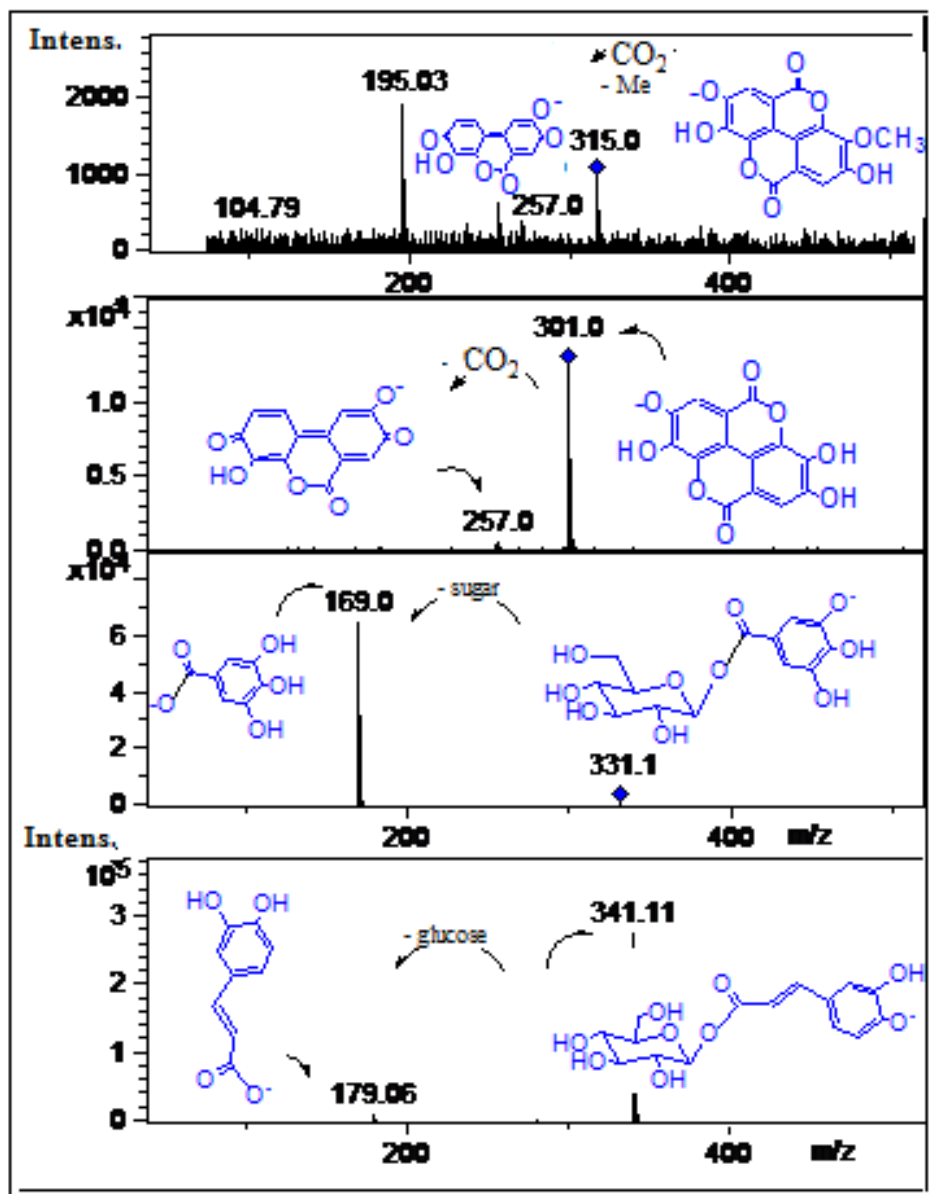
Figure 8. Structures, fragmentation, full ESI-MS and MS-MS spectra of peaks 8 , 11 , 20 and 21